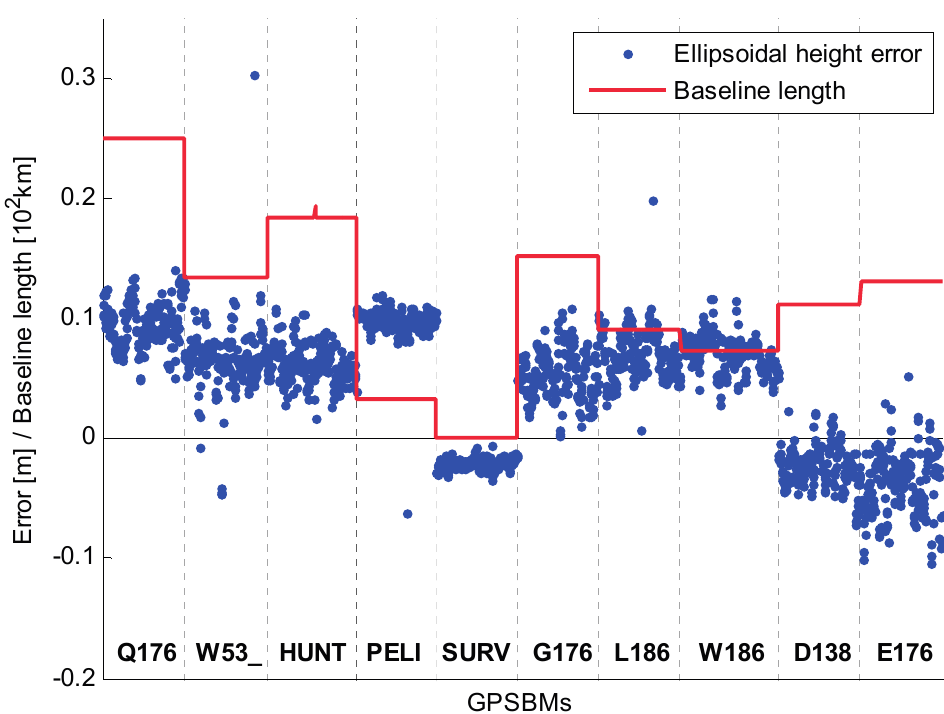
Figure 9. Errors and baseline lengths by antenna type (TRMR8_GNSS NONE) for Phase